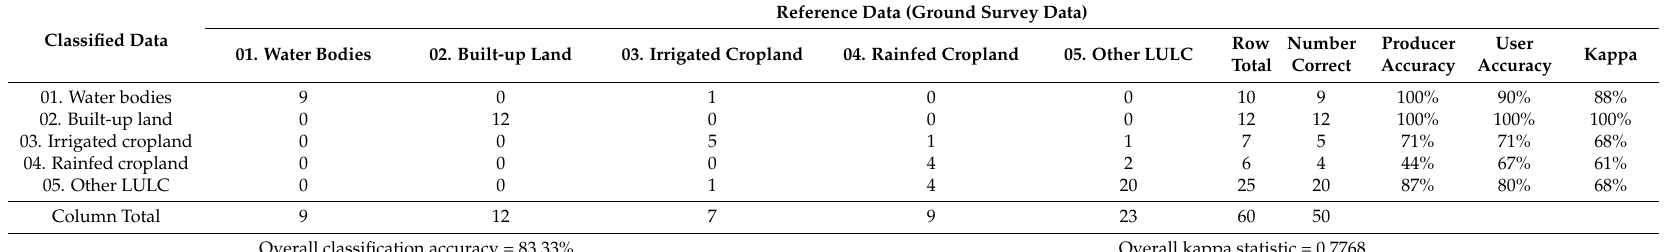
Table 4. Validation of land-use/land-cover (LULC) classes in 2011, based on ground survey data.